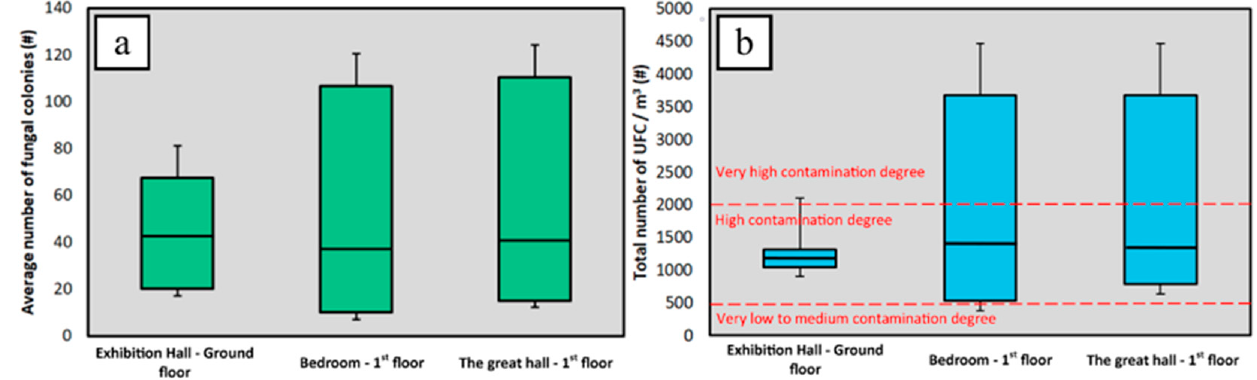
Figure 4. The degree of fungal contamination of the air inside the three analyzed rooms of the Darvas-La Roche House (( a )—the average number of fungal colonies; ( b )—the total number of fungal units that form colonies, calculated per m 3 of indoor air).